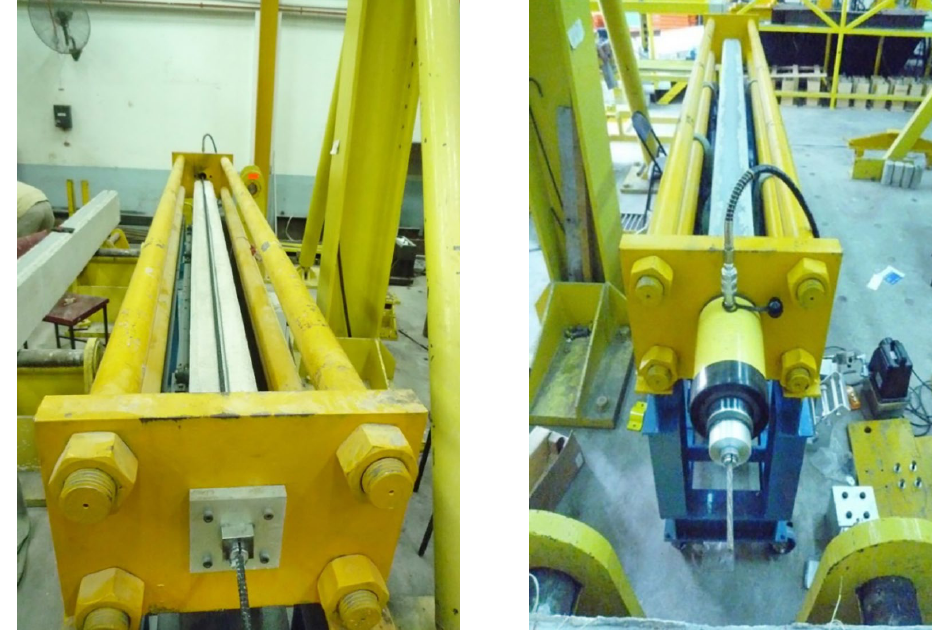
Figure 2. Prestressing system